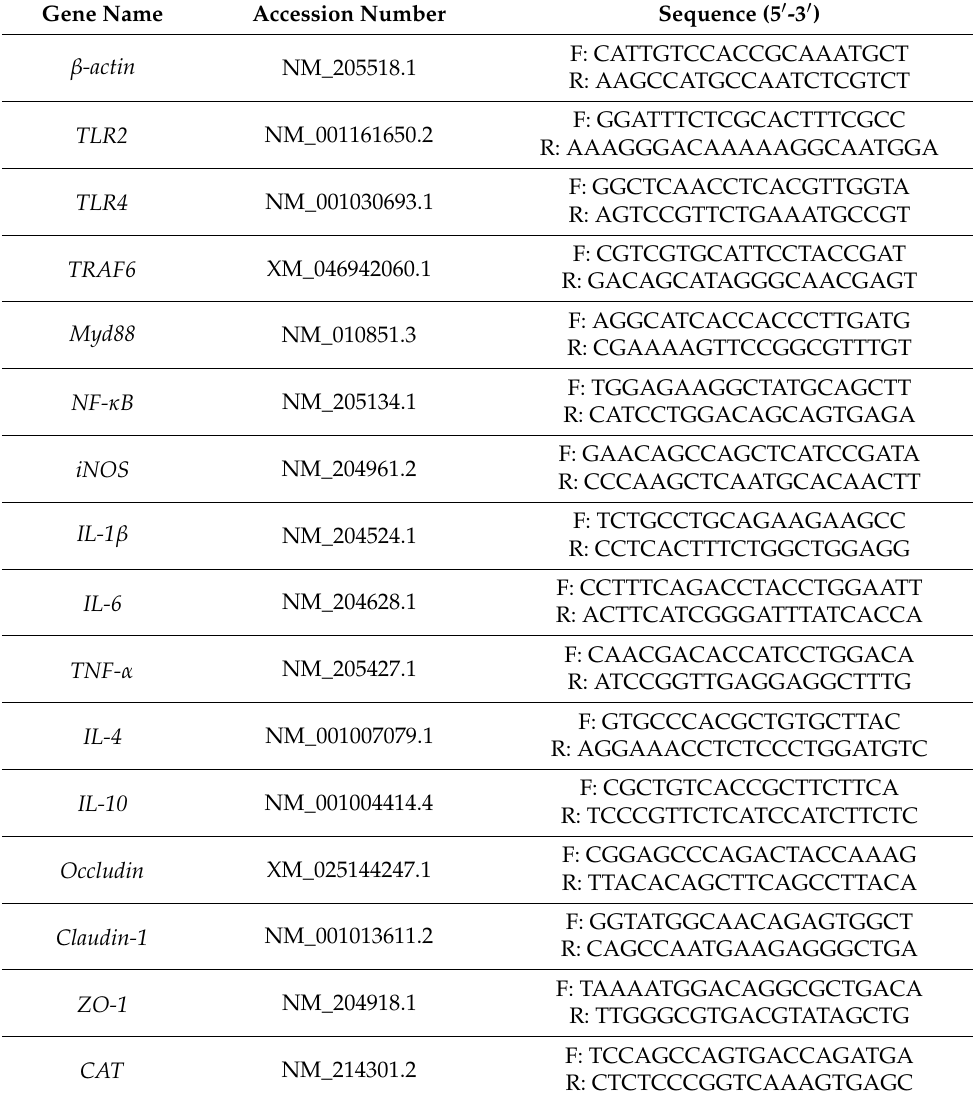
Table 2. Sequences of the oligonucleotide primers used for quantitative real-time PCR 1